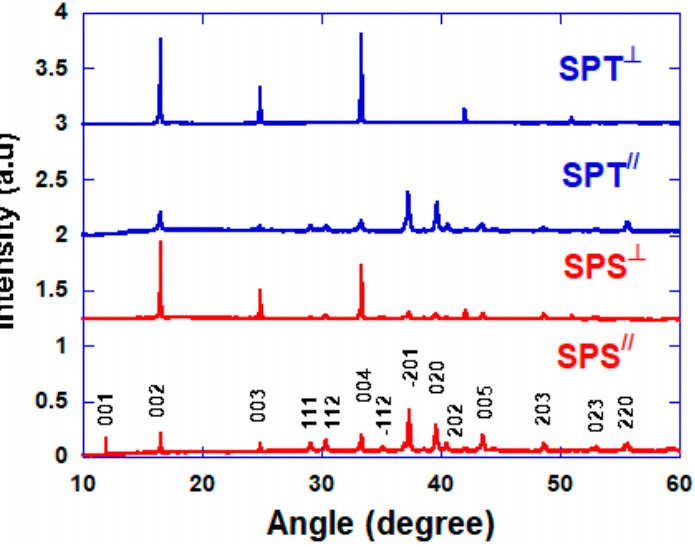
Figure 3. XRD diffraction curves were obtained, from the faces perpendicular and parallel to the applied pressure during Spark Plasma Sintering (SPS, red color) and Spark Plasma Texturing (SPT, blue color).